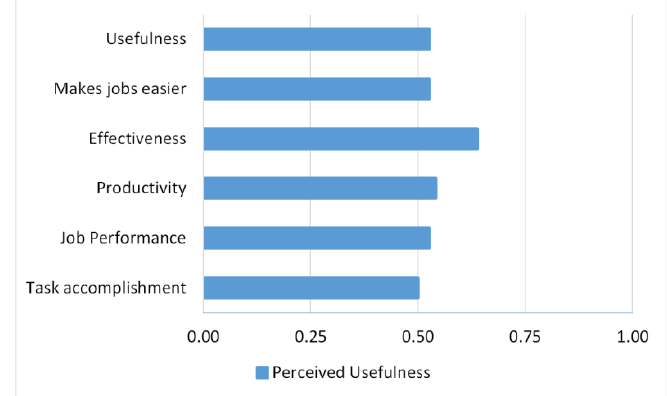
Fig. 2 . Perceived usefulness according to component developers (normalized scores).